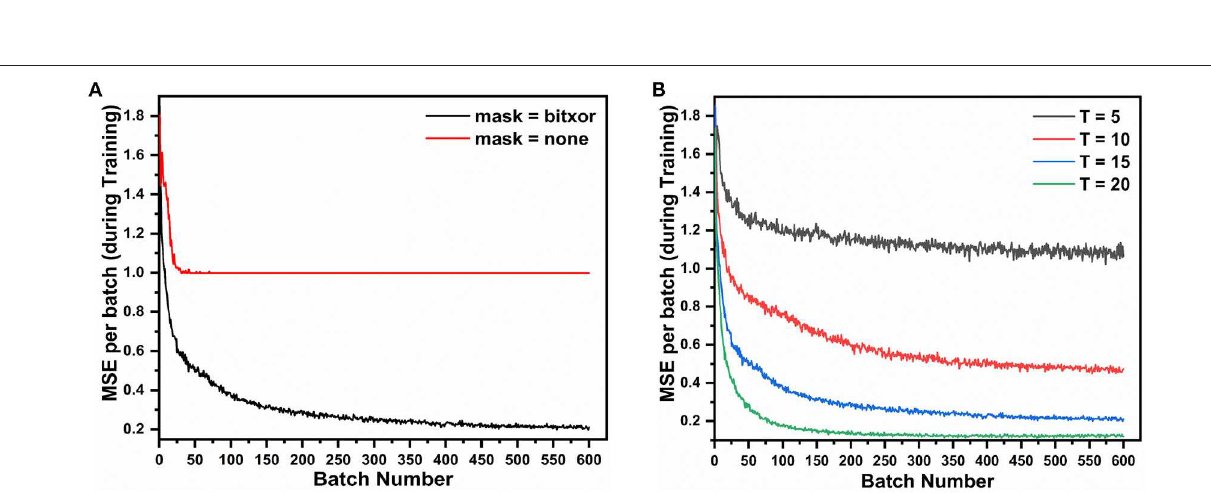
FIGURE 4 | The AE-SNN (784-196-784) is trained over MNIST (60,000 training samples, batch size = 100) and we study the impact of (A) mask and (B) input spike train duration on the Mean Square Error (MSE) Reconstruction Loss.